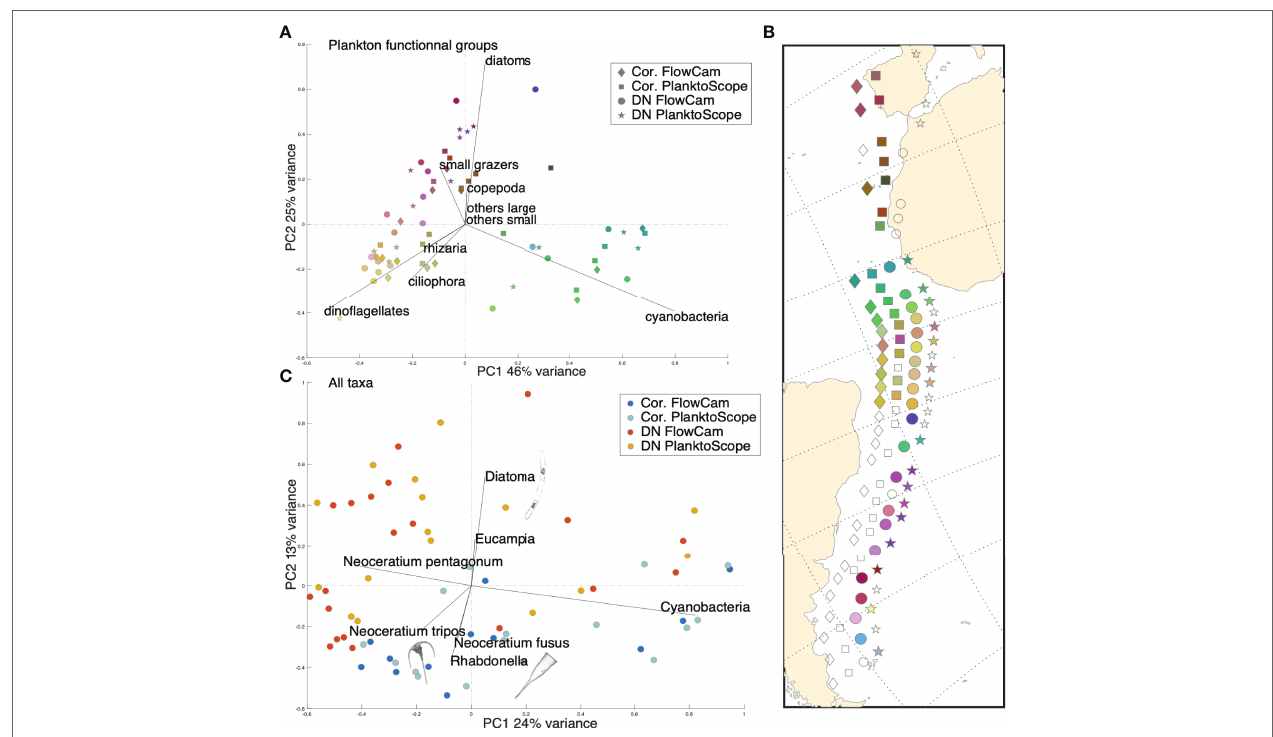
FIGURE 3 | (A) PCA performed on microplankton functional composition (Hellinger transformed data, 9 taxo-functional groups). The 4 instrumental configurations (sampling-imaging devices couples) are represented by the 4 different shapes. Colors are derived from the position of the points on the first 3 axes of the PCA. (B) Geographic projection of each point along the Tara Atlantic transect (exact position of the stations: diamond shape Cor. FlowCam). The empty shapes represent the instrumental configurations deployed but not selected in our analysis (see Figure 2 and section: Instrument’s Quality Control ). (C) PCA performed on microplankton taxonomic composition (Hellinger transformed data; 179 taxa). The 4 instrumental configurations are represented by the 4 different colors. Only taxa with a contribution greater than 0.23 to the PCA axes are shown for ease of reading. Plankton images taken as examples are from FlowCam; the image close to ‘Diatoma’ corresponds to a diatom of the genus Hemiaulus, the image close to ‘Rhabdonella’ corresponds to a ciliate of the genus Rhabdonella and the image close to ‘Neoceratium tripos’ corresponds to a dinoflagellate of the species Neoceratium tripos